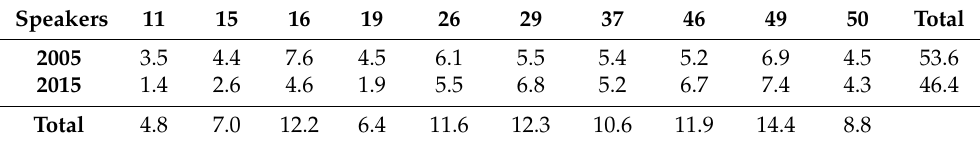
Table 2. Breakdown of productions, as a percentage of 1383 tokens, for each speaker and time. Positional contexts for euh were initial, internal, and end.